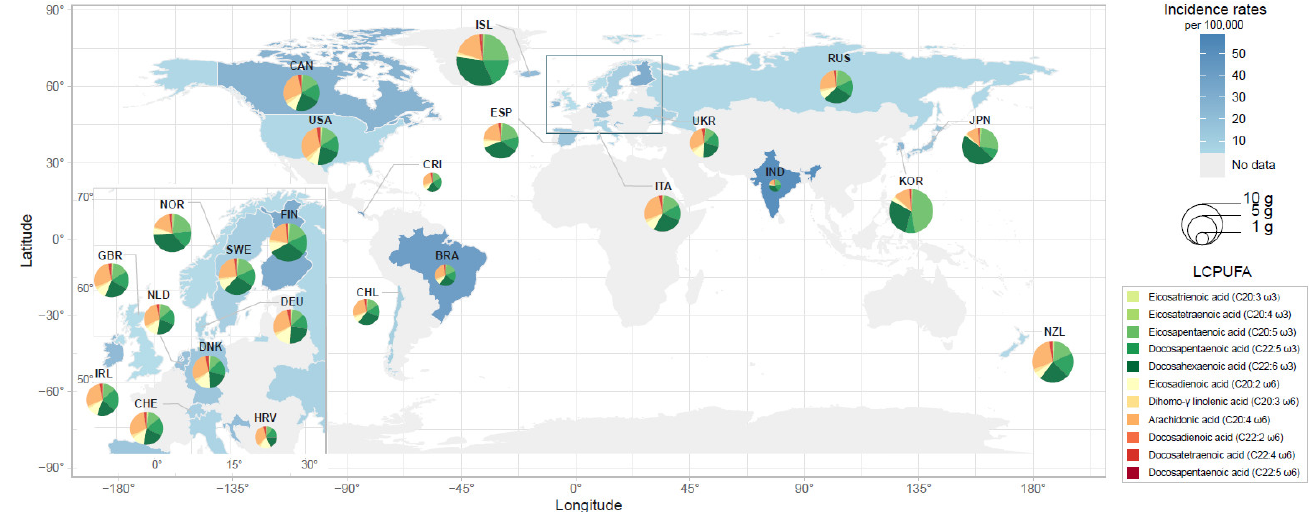
Figure 2. Incidence rates and estimated daily LCPUFA intakes for countries. Darker blue signifies higher incidence rates of schizophrenia and lighter blue signify lower rates. Grey tones indicate that the incidence rates of schizophrenia in these countries were not available in this study. The size of the pie chart is proportional to the dietary intake of total LCPUFAs. The NUTTAB contained 11 LCPUFAs in total, which green colors represent ω-3 LCPUFAs and orange colors represent ω-6 LCPUFAs. The area outlined by the dark-blue box zoomed into the lower left corner of this figure.